Question: Sum up the contents of this chart in one sentence.
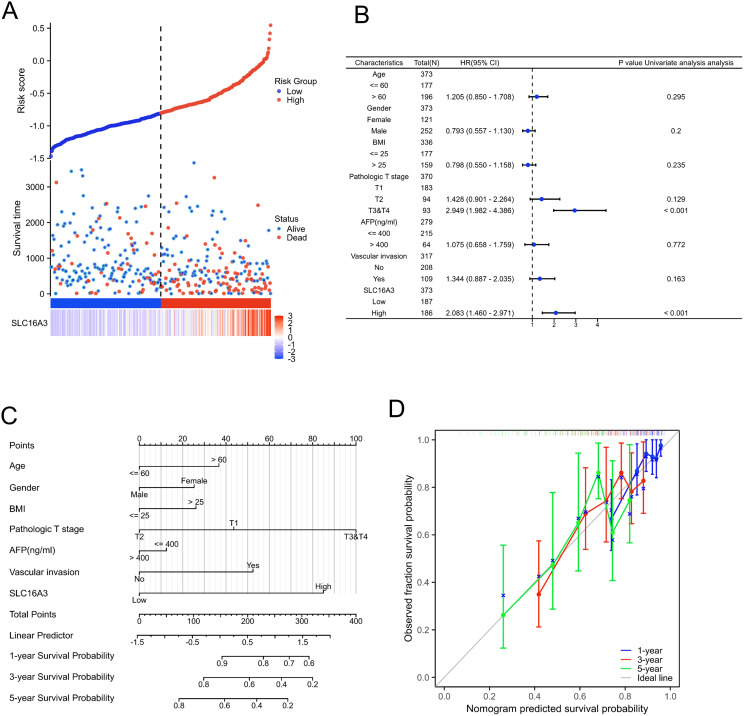
Answer: Prognostic value of SLC16A3 expression level in HCC. (A) SLC16A3 expression distribution and survival status. (B) Forest plot of OS by multivariate Cox regression analysis in HCC from TCGA database. (C) The nomogram for predicting 1-, 3-, or 5-year OS rates in patients with HCC. (D) The calibration curves for the nomogram.